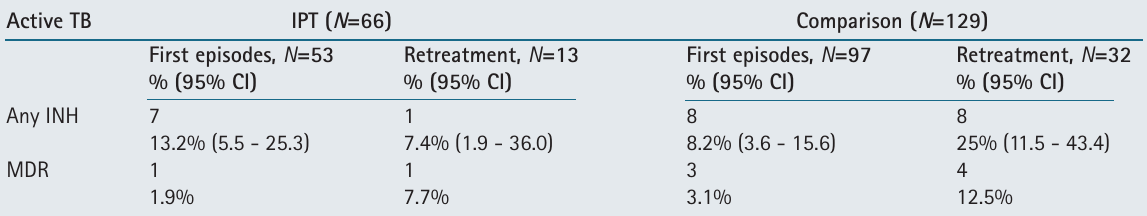
tABLe I. preLImInArY DrUG SUSCeptIBILItY of tB on